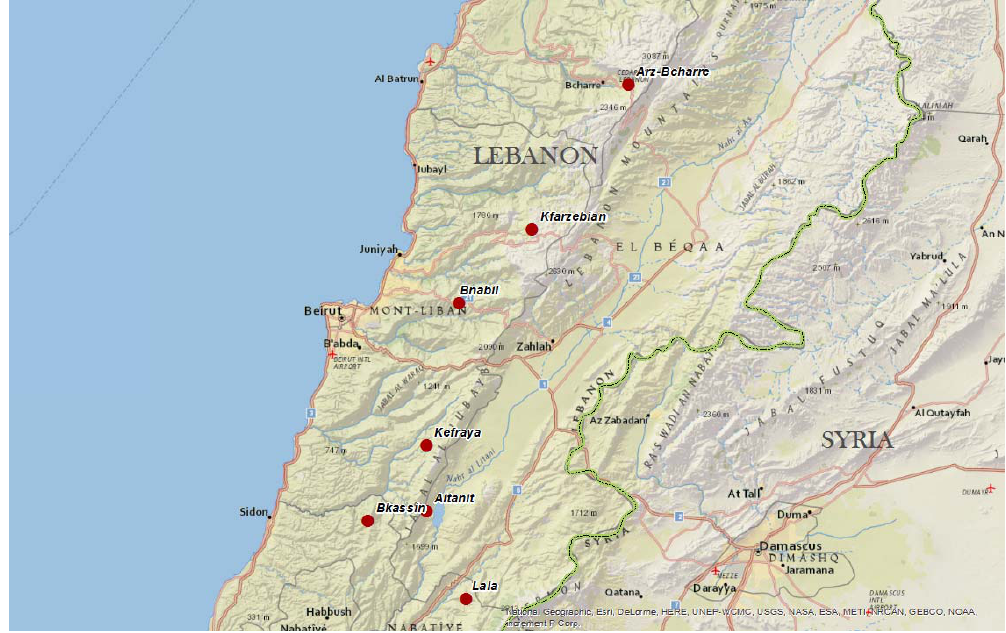
Figure 2. Field trial sites.